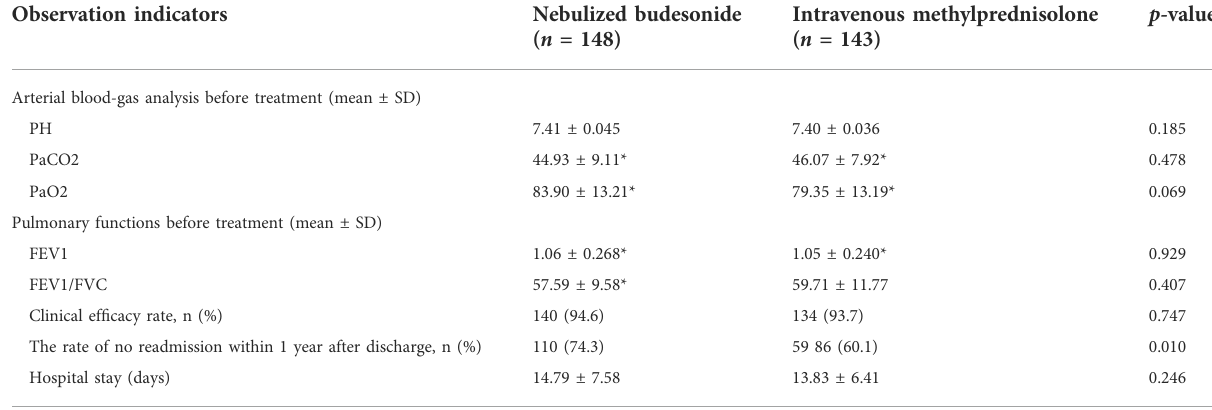
TABLE 2 Comparison of effectiveness of nebulized budesonide and intravenous methylprednisolone. Observation indicators